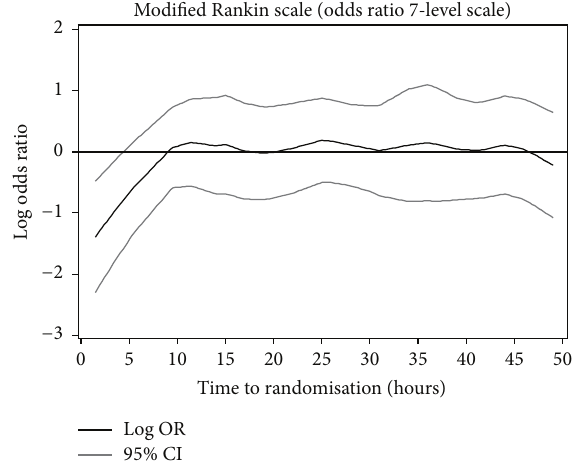
Figure 2: Effect of glyceryl trinitrate versus no glyceryl trinitrate on functional outcome (modified Rankin scale) at 90 days by time to randomisation.